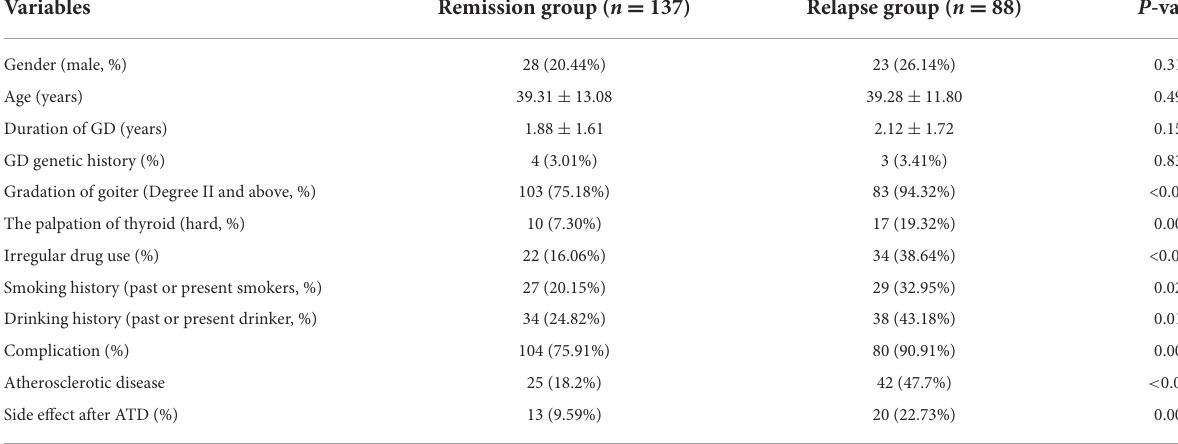
TABLE 2 Clinical baseline of patients in the drug reduction group.